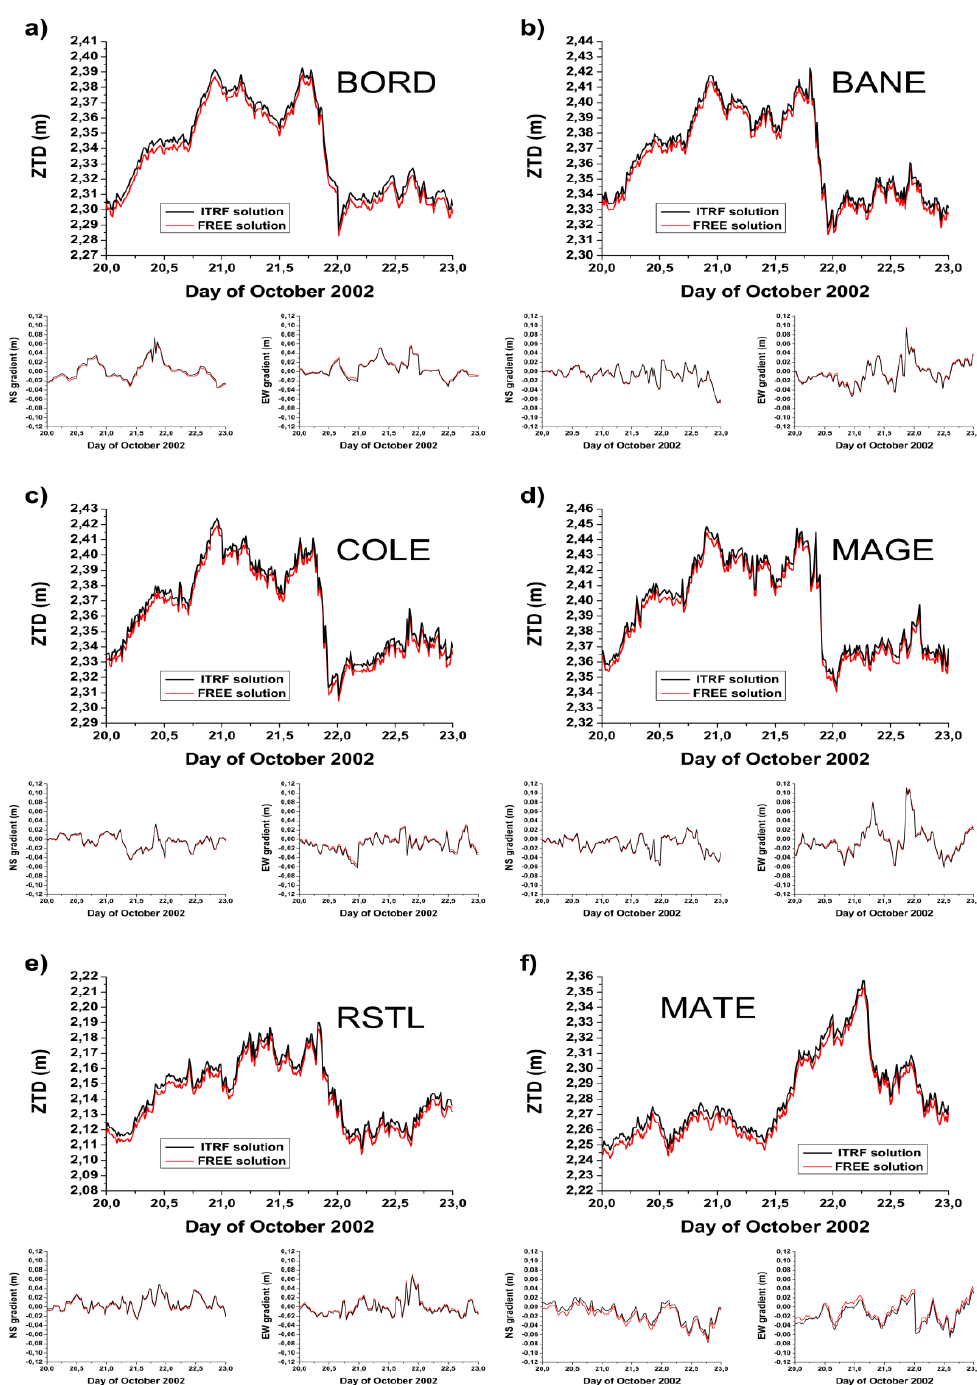
Fig. 4. Comparison of ZTDs and GRADs (NS and EW components) evaluated in a “free” and an “ITRF” reference frame. The same 6 stations as in Fig. 3 are shown in the reference network configuration over the same period from 20–22 October 2002 (day of year 293–295). Standard constraints on tropospheric parameter variability are applied in both solutions. Quantification of biases and standard deviations are resumed in Table 2.